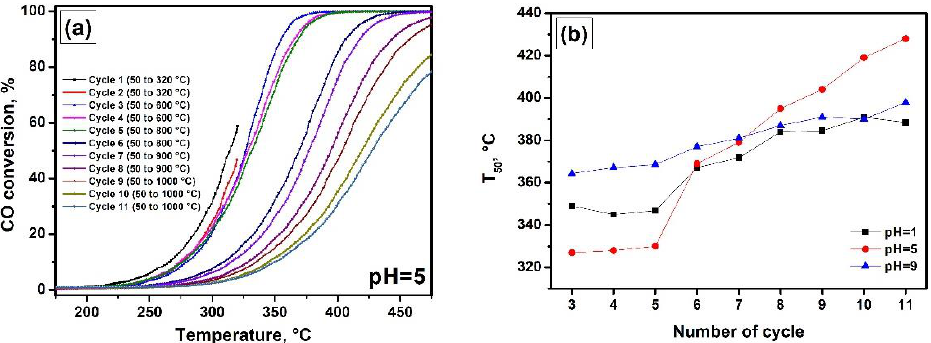
Figure 7. Temperature dependence of CO conversion in a prompt thermal aging regime for the Ni-Mg-O sample obtained at pH = 5 ( a ); thermal stability curves for the Ni-Mg-O samples obtained at various pH ( b ).